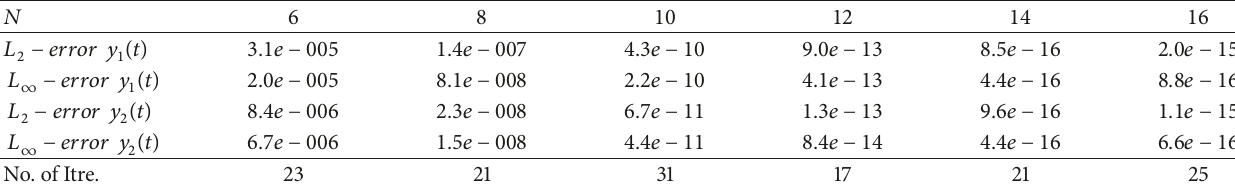
Table 1: The 𝐿 2 and 𝐿 ∞ errors for Example